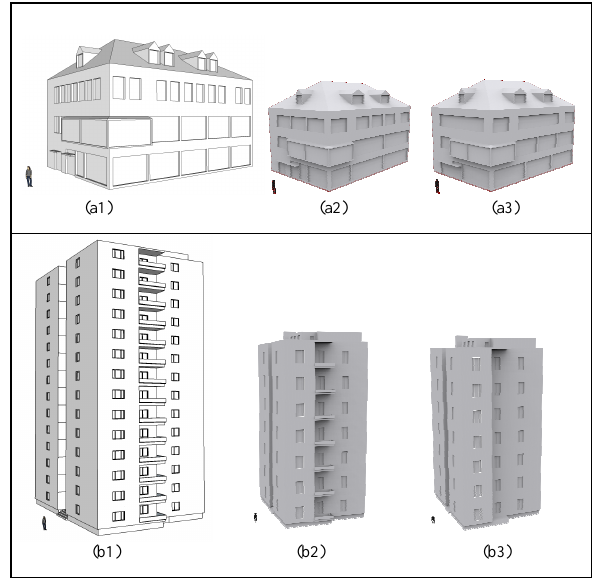
Figure 2. First application for conclusions drawn from the survey. For x ∈ {a,b}: (x1) original building model, (x2) abstraction based on features important for the user to classify into the respective correct category, (x3) 'free' abstraction without